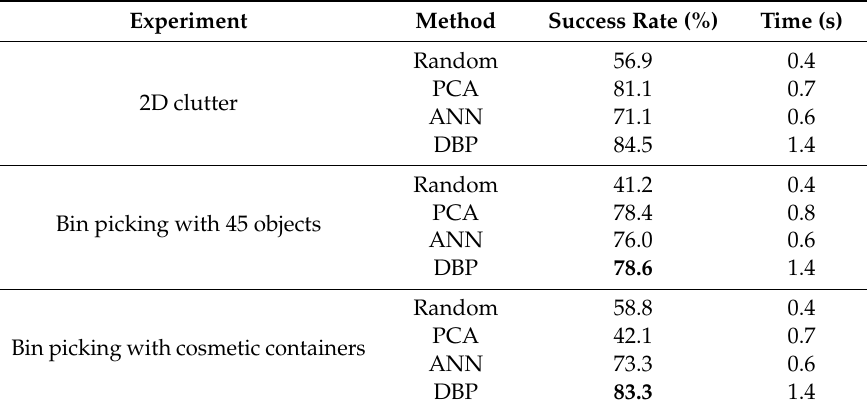
Table 1. Grasping success rates in the three